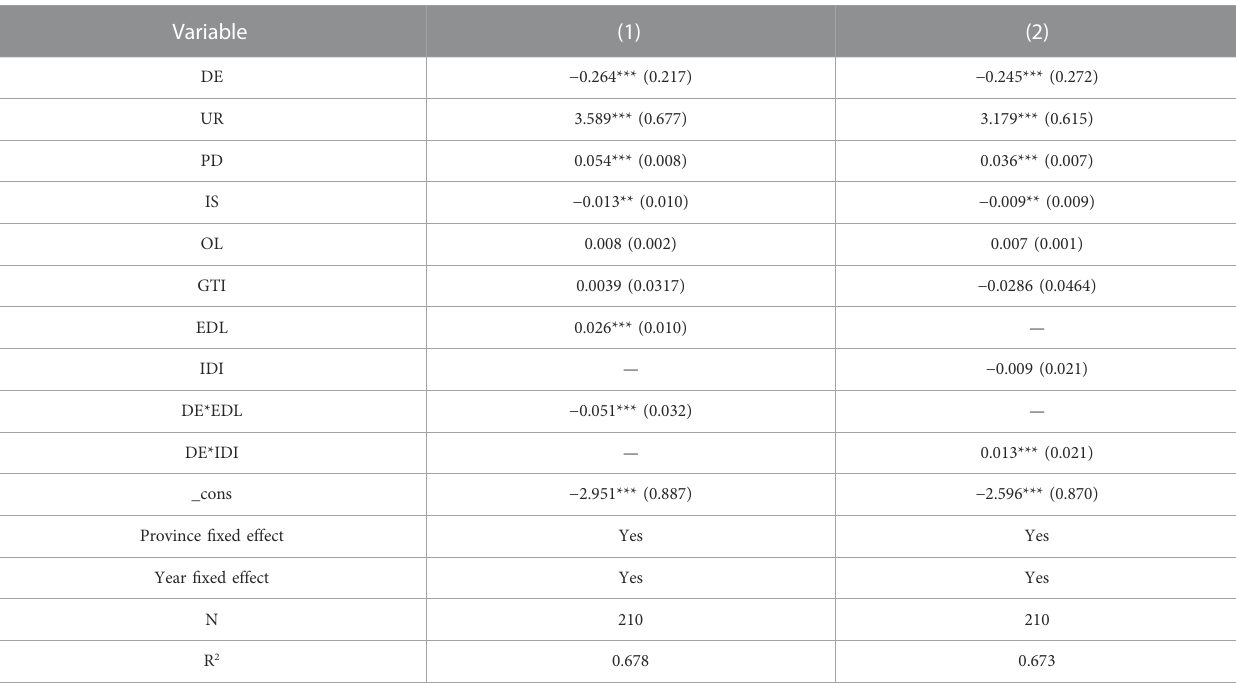
TABLE 5 Moderating effect